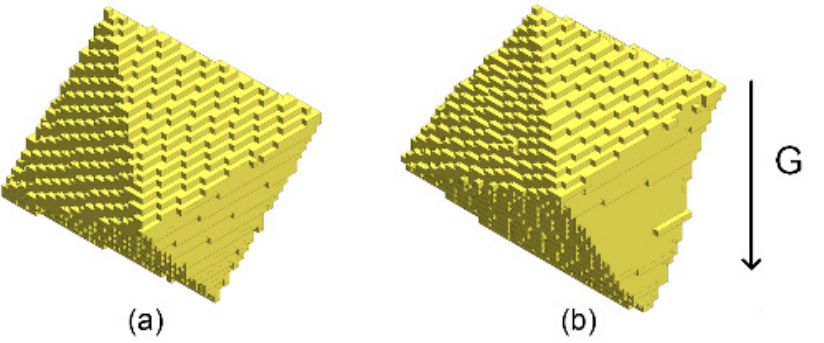
Figure 4. Numerical predictions of a single grain envelope 7 s after nucleation with an initial undercooling of 2 K and a constant cooling rate of − 0.1 K/s. The temperature gradients are 0 K/m for case ( a ) and 250 K/m for case ( b ), respectively. The arrow indicates the direction of the temperature gradient vector G .